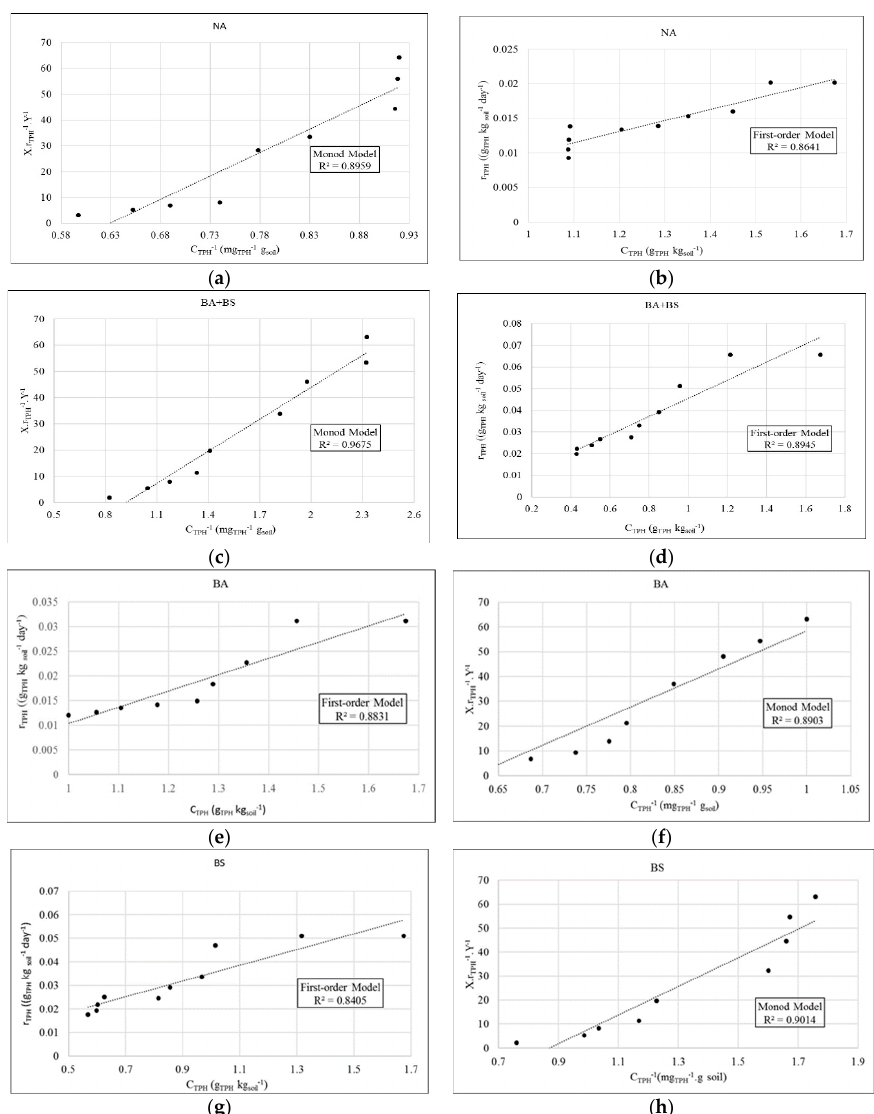
Figure 5. Reaction rate data for the treatment modes. ( a ) The first ‐ order model for NA, ( b ) the Monod model for NA, ( c ) the first ‐ order model for BA+BS, ( d ) the Monod model for BA+BS, ( e ) the first ‐ order model for BA, ( f ) the Monod model for BA, ( g ) the first ‐ order model for BS, ( h ) the Monod model for BS.